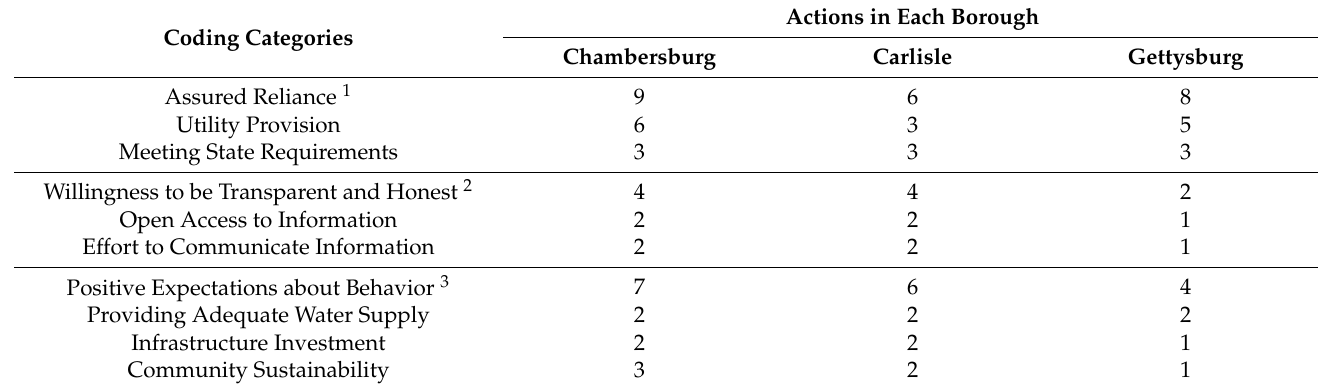
Table 1. Summary of building and maintaining trust